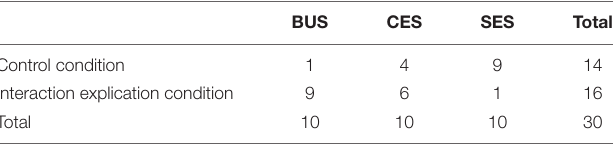
TABLE 9 | Distribution of strategies across